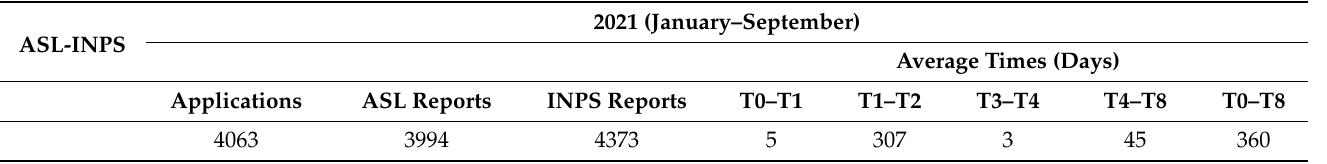
Table 2. Iglesias summary data: applications, ASL and INPS reports, and average times of procedure.